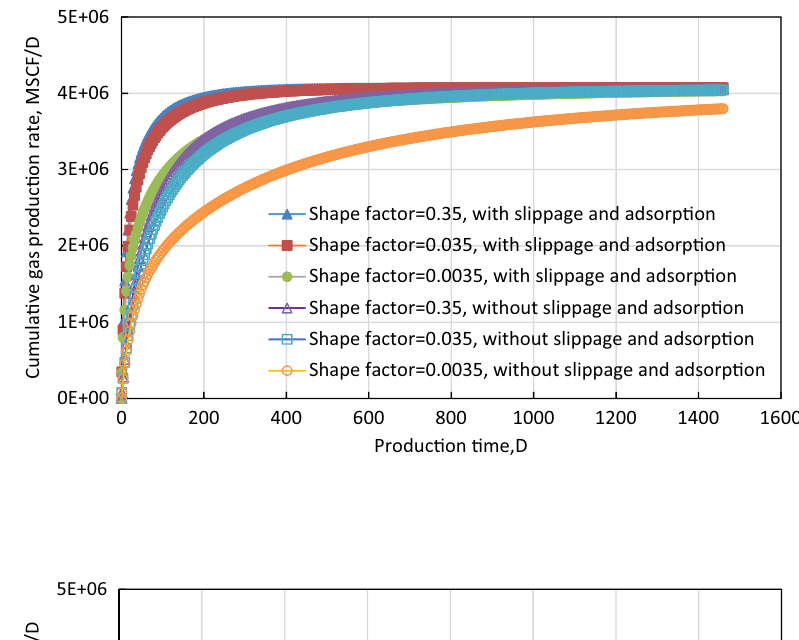
Fig. 7 Performance of dual- porosity shale gas reservoir with different natural fracture permeability